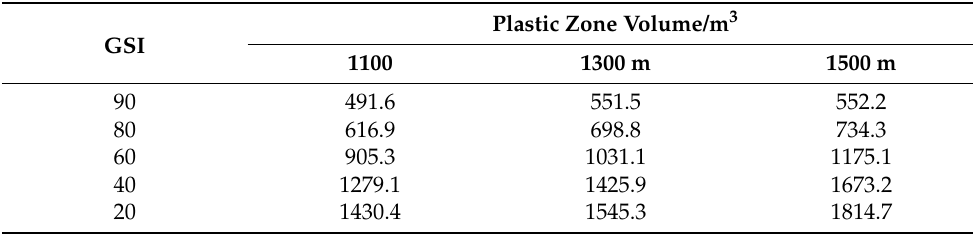
Figure 6. Numerical model. Table 5. Plastic zone volume of roadway under different rock mass